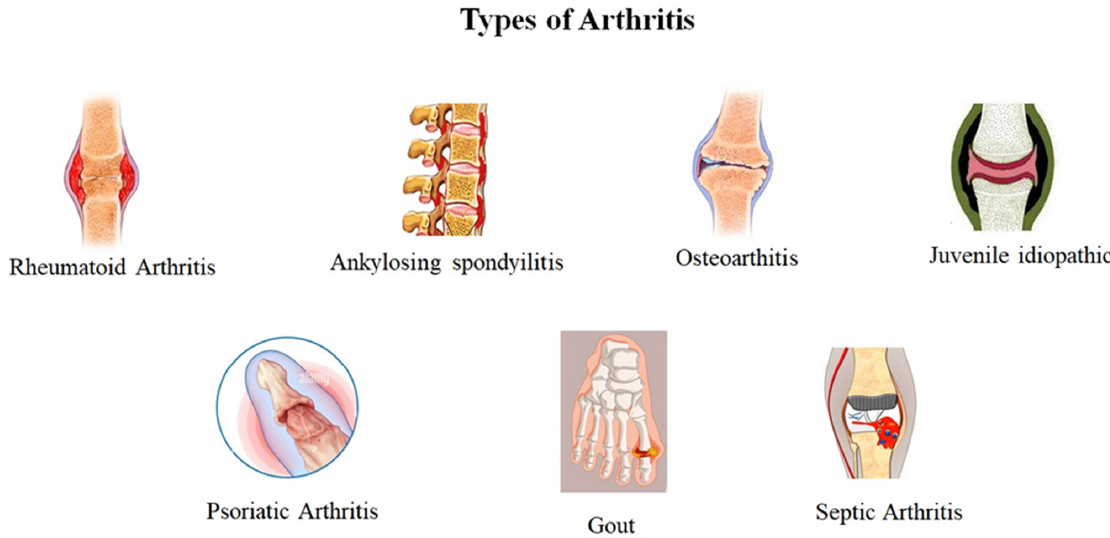
Figure 1. Common types of arthritis reported in the literatures.